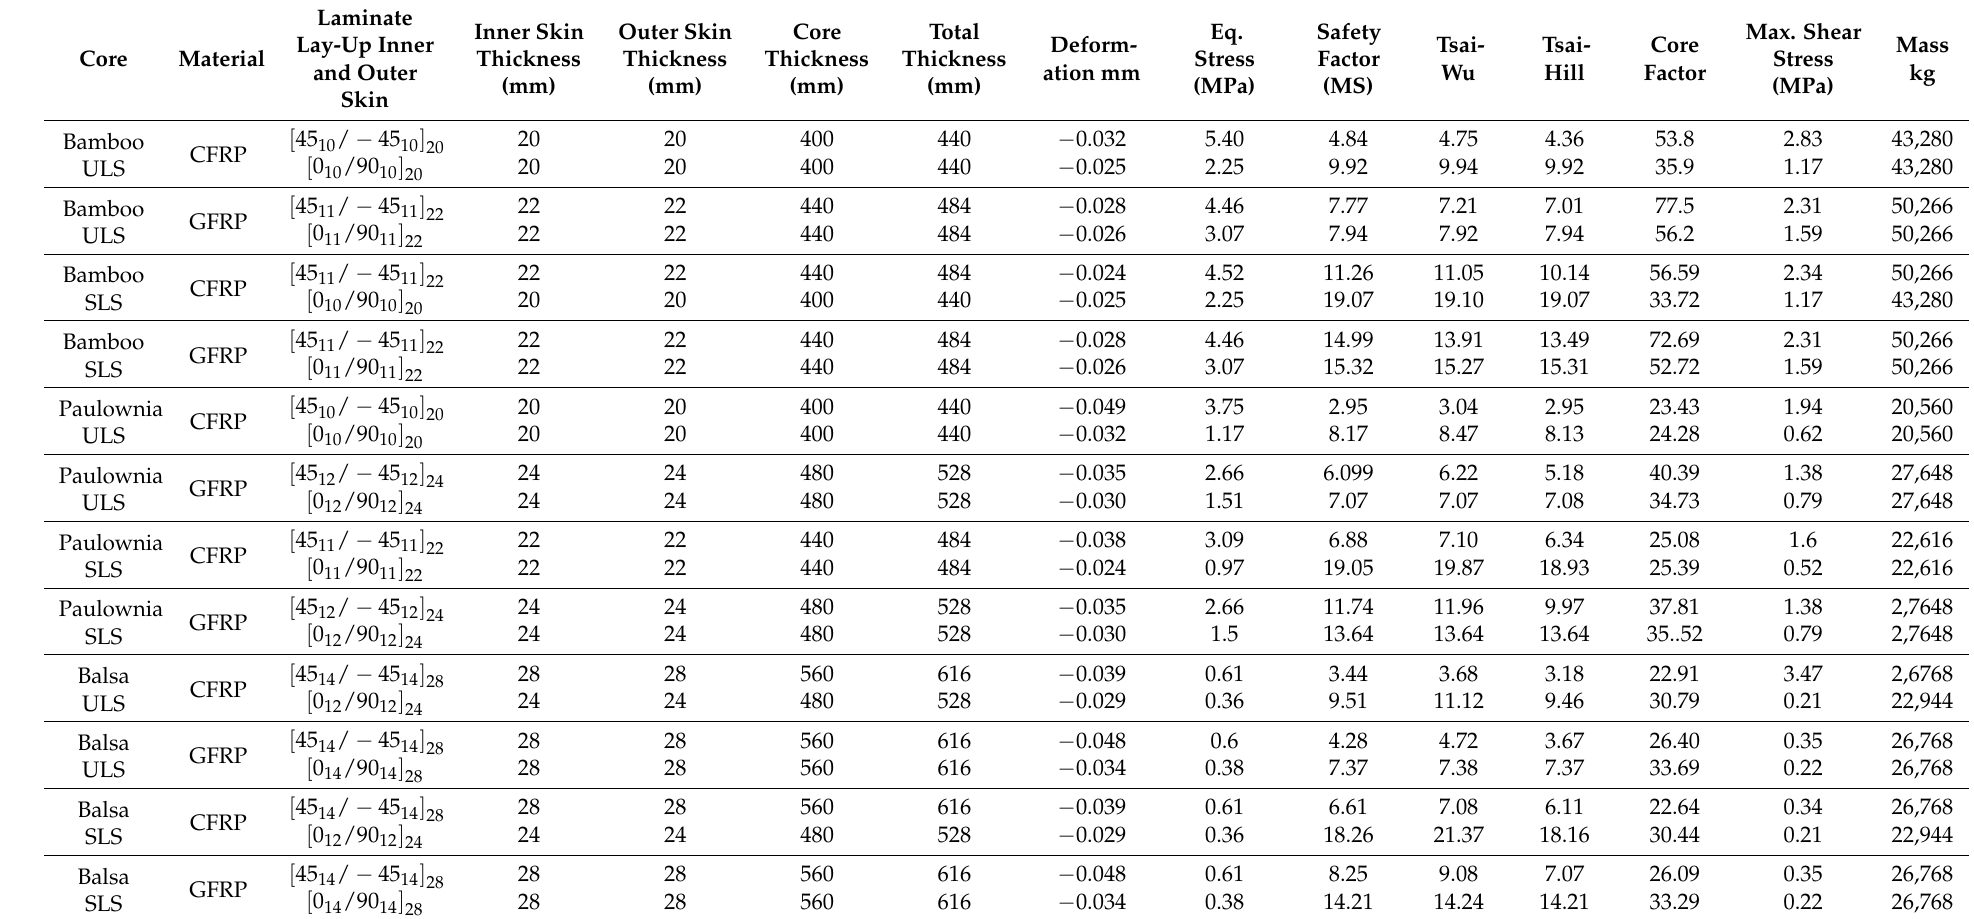
Table 4. FEA Results for all bridge configurations under ULS and SLS